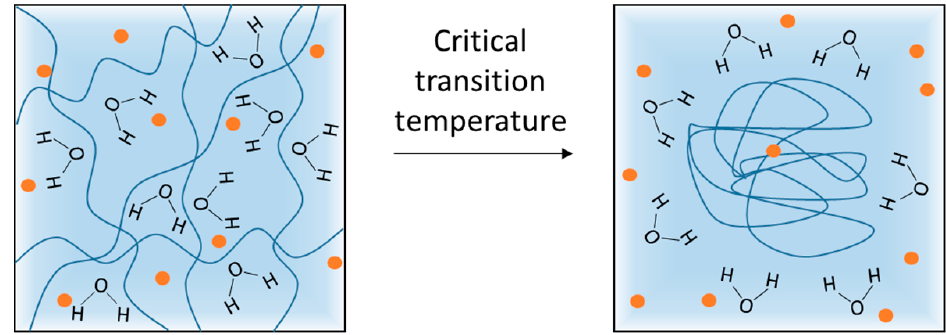
Figure 4. Schematic illustration of LCST hydrogel behavior.